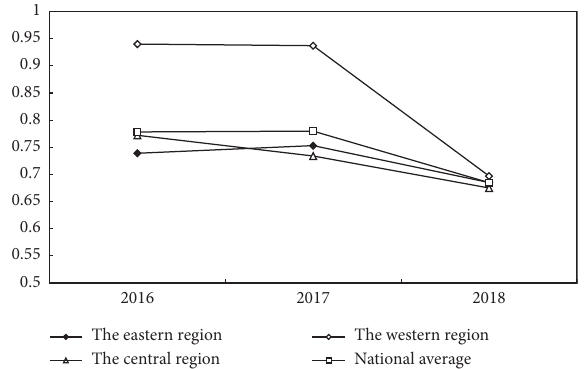
Figure 4: Green innovation social output efficiency of listed energy companies in China from 2016 to